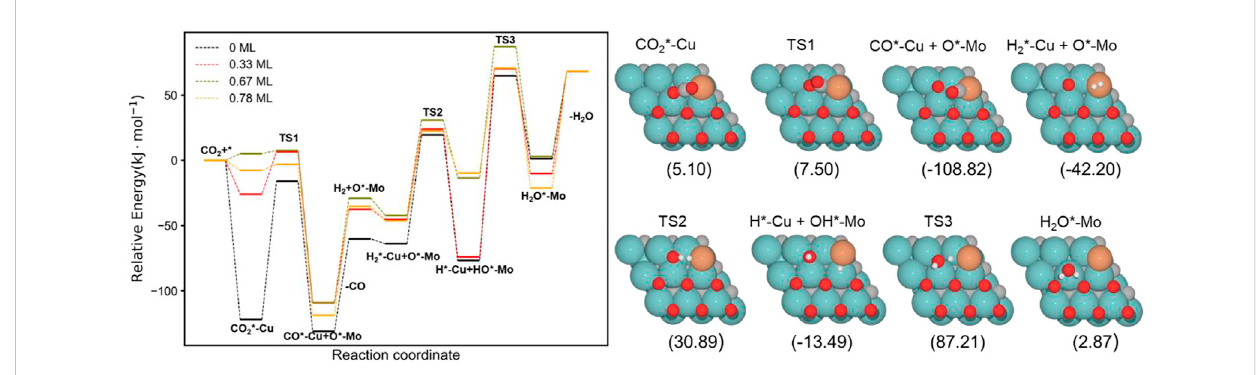
FIGURE 8 Energypro fi leofRWGSreactiononCu/Mo 2 CwithdifferentOMLcoverage;black,red,green,andorangelinesindicatesurfaceoxygencoveragesof 0, 0.33, 0.67, and 0.78, respectively. The intermediate and transition state structures and their energies are shown on the right for the 0.67 O ML case. Energies are referenced against the sum of the initial reactants ’ energy in kJ mol – 1 (E rel